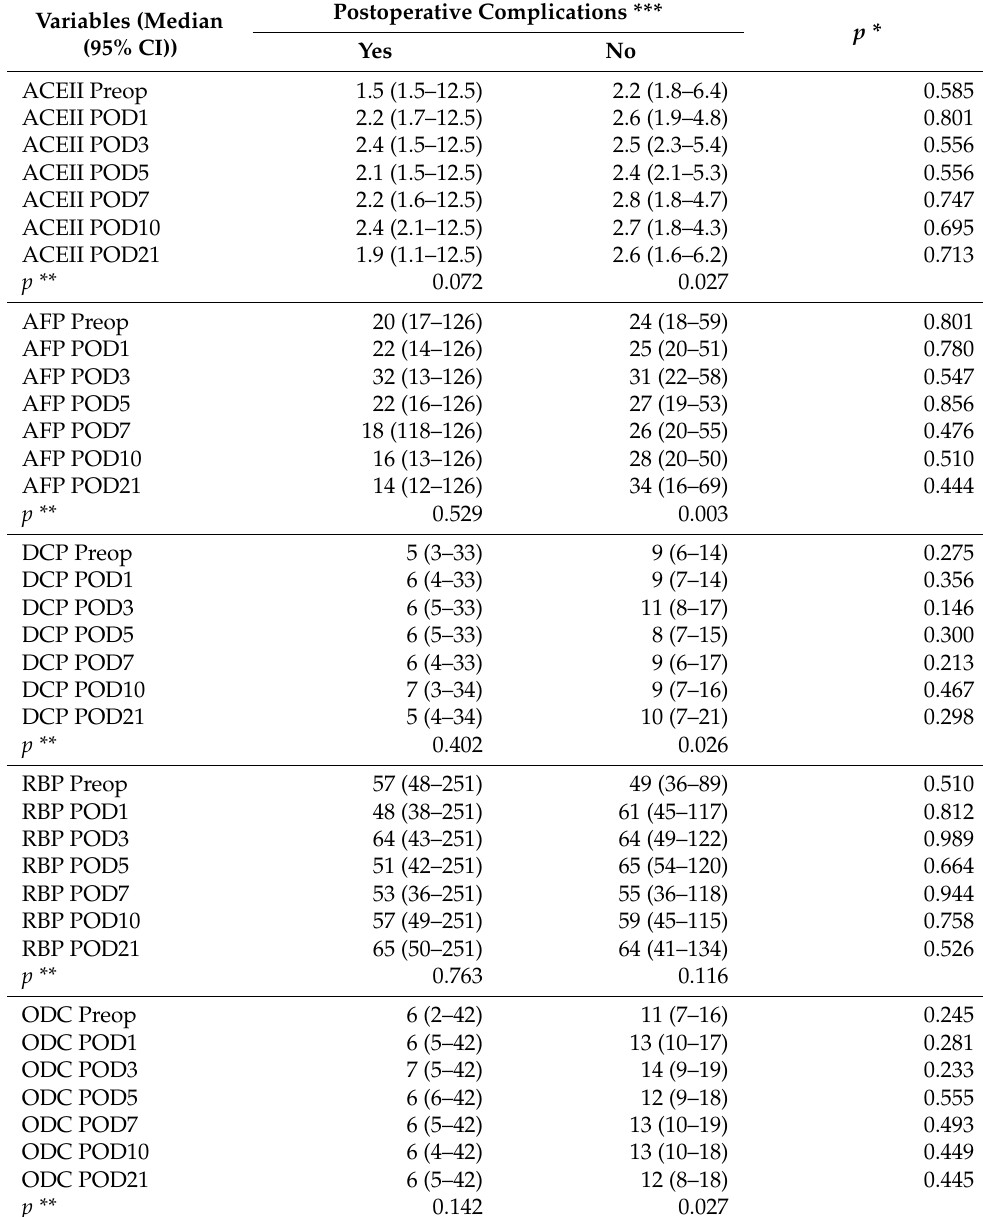
Table 6. Comparison of the study subgroups created according to the postoperative complications status in terms of regeneration-related biochemical